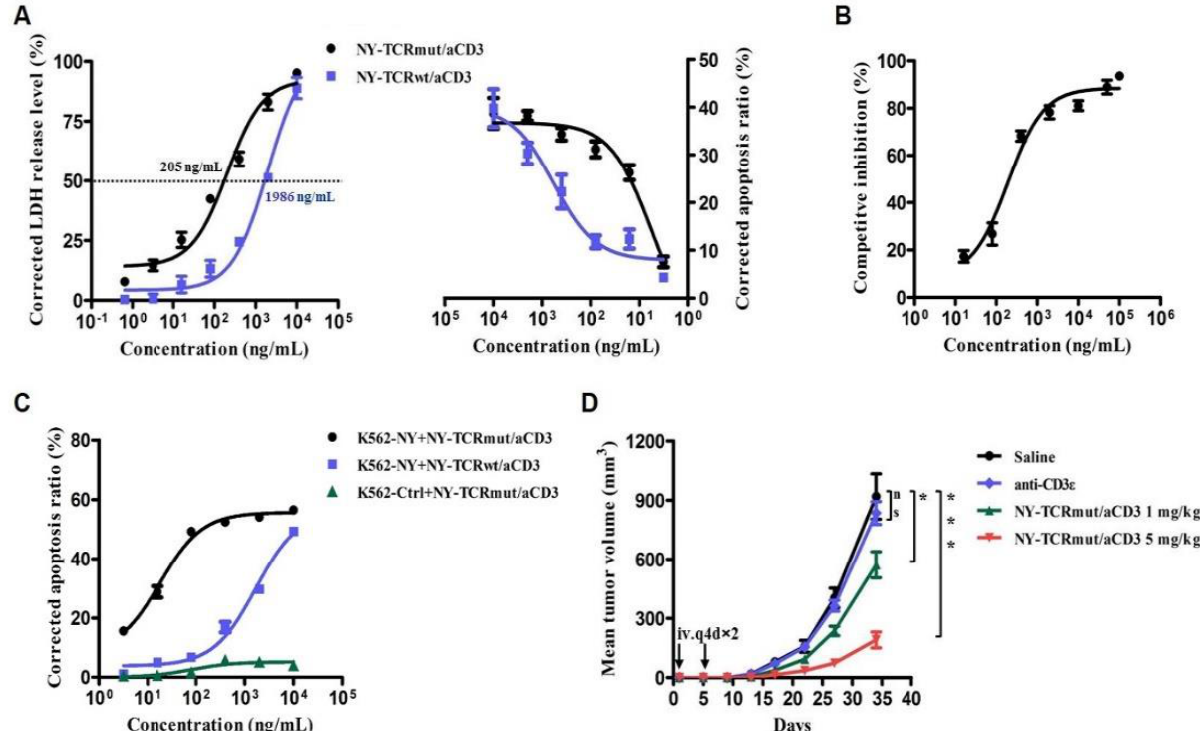
Figure 4. NY-TCR/aCD3 redirected ATC to specifically kill NY/A02 + tumor cells. ( A ) Lysis of A375 or A375-eGFP cells over 24 h caused by ATC in the presence of titrated concentrations of NY-TCR/aCD3. Lysis was determined through cell apoptosis assay (n = 3, right) or LDH release assay (n = 3, left). ( B ) Competitive inhibition of NY-TCRmut/aCD3 activity by NY/A02 (n = 3). The lysis level was determined by LDH release assay and competition inhibition = LDH concentration of the test group/LDH concentration of the control group (0 ng/mL NY/A02). ( C ) Lysis of K562-based tumor cells 24 h caused by ATC in the presence of titrated concentrations of NY-TCR/aCD3 (n = 3). Lysis was determined through cell apoptosis assay. ( D ) In vivo efficacy of NY-TCRmut/aCD3 in the beige-SCID xenograft model (n = 5). Beige-SCID mice engrafted with A375 cells (2 × 10 6 ) and ATC (4 × 10 6 ) were treated with NY-TCRmut/aCD3 with a dose of 1 mg/kg and 5 mg/kg. The blank group and control group mice were dosed with saline and anti-CD3 ε antibody, respectively. At day 34, the difference between the 5 mg/kg group compared to the blank group was highly significant ( p = 0.0003). The difference between the 1 mg/kg group compared to the blank group was significant ( p = 0.0313), and there was no significant difference between the control group and blank group ( p = 0.5343). Data are means ± SEM. p < 0.05, * p < 0.01, *** p < 0.001, n.s p >